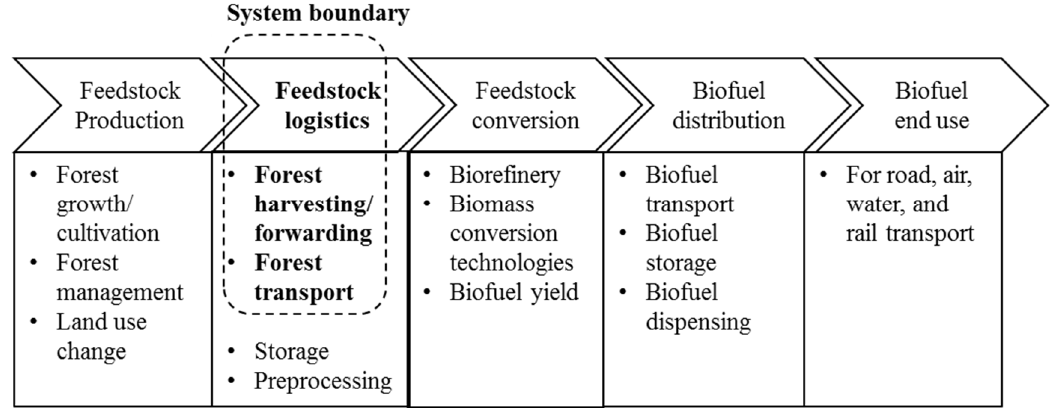
Figure 1. Diagram of system boundary for life-cycle assessment of the forest biomass supply